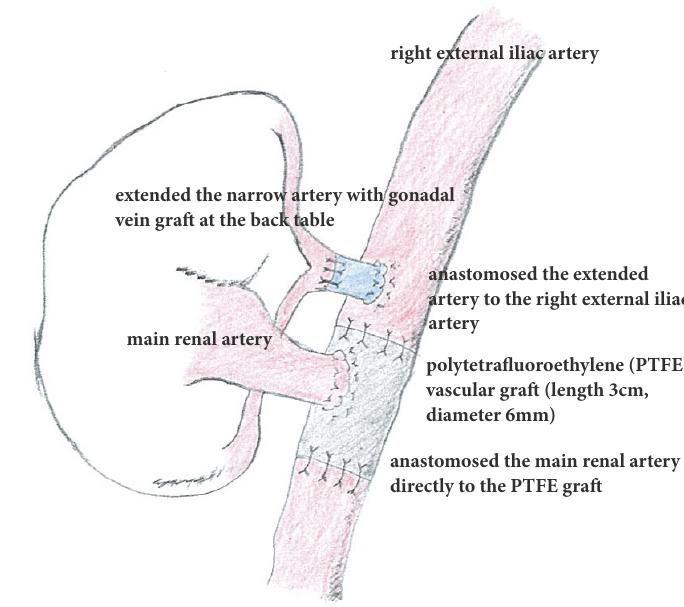
Figure 1: An illustration of aortoiliac reconstruction using polytetrafluoroethylene vascular graft.